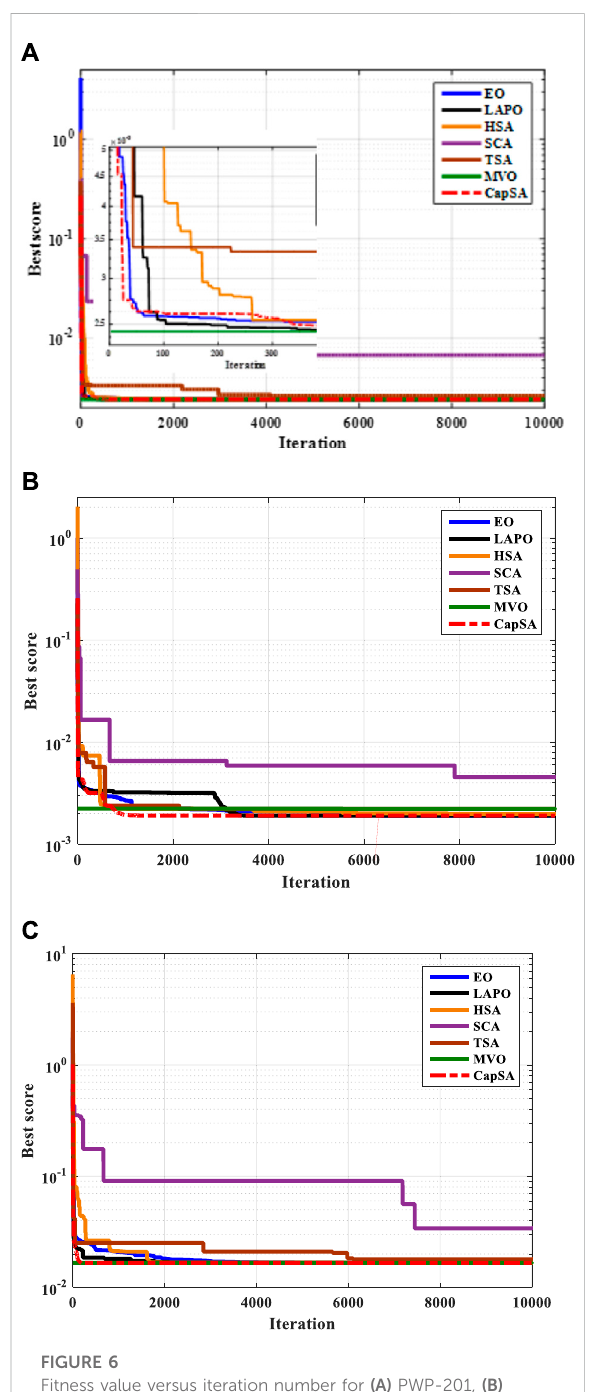
FIGURE 6 Fitness value versus iteration number for (A) PWP-201, (B) STM6-40/36, and (C) STP6-120/36